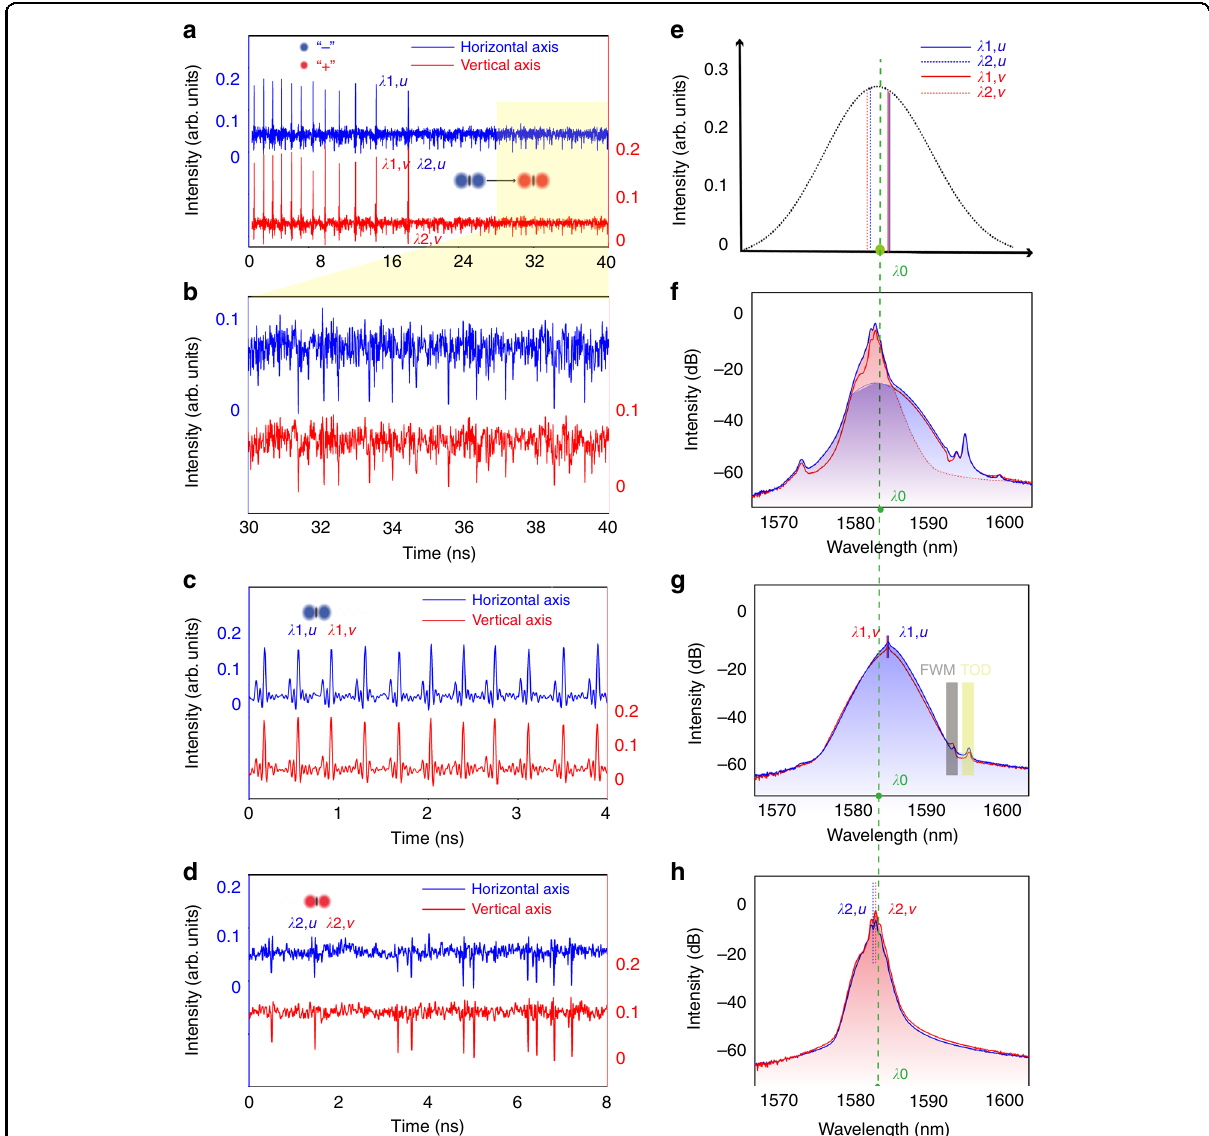
Fig. 6 Coexistence of vector BSs and DSs. a State of coexistence of vector BSs and DSs. b Zoom-in of the vector DSs in the time window from 30 to 40 ns as shown in ( a ). c State of vector BSs. d State of vector DSs. e Schematic of the laser gain curve. Central wavelengths of the BSs and DSs across the ZGVD point, λ 0 : the position of ZGVD point, λ 1, u : central wavelength of BSs formed along the horizontal polarization axis, λ 2, u : central wavelength of the DSs formed along the horizontal axis, λ 1, v : central wavelength of the BSs formed along vertical polarization axis, λ 2, v : central wavelength of DSs formed along vertical polarization axis. f – h Optical spectra of ( a , and c , d ). f Red color part: fi tted spectrum of the vector DSs according to ( h ), blue color part: fi tted spectrum of the vector BSs according to ( g ). g Spectrum for BSs. h Spectrum for